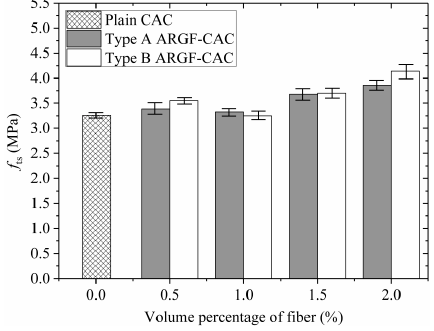
Figure 11. Variation of f ts with fiber content.